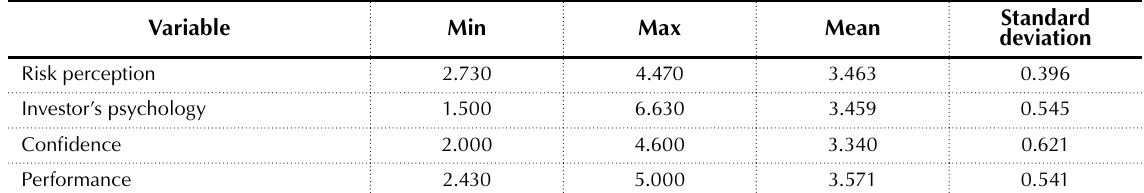
Table 7. Descriptive statistics (N = 100)